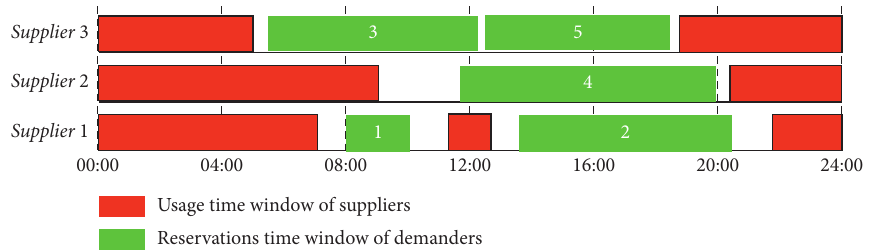
Figure 1: Supplementary graph of supply and demand for shared parking